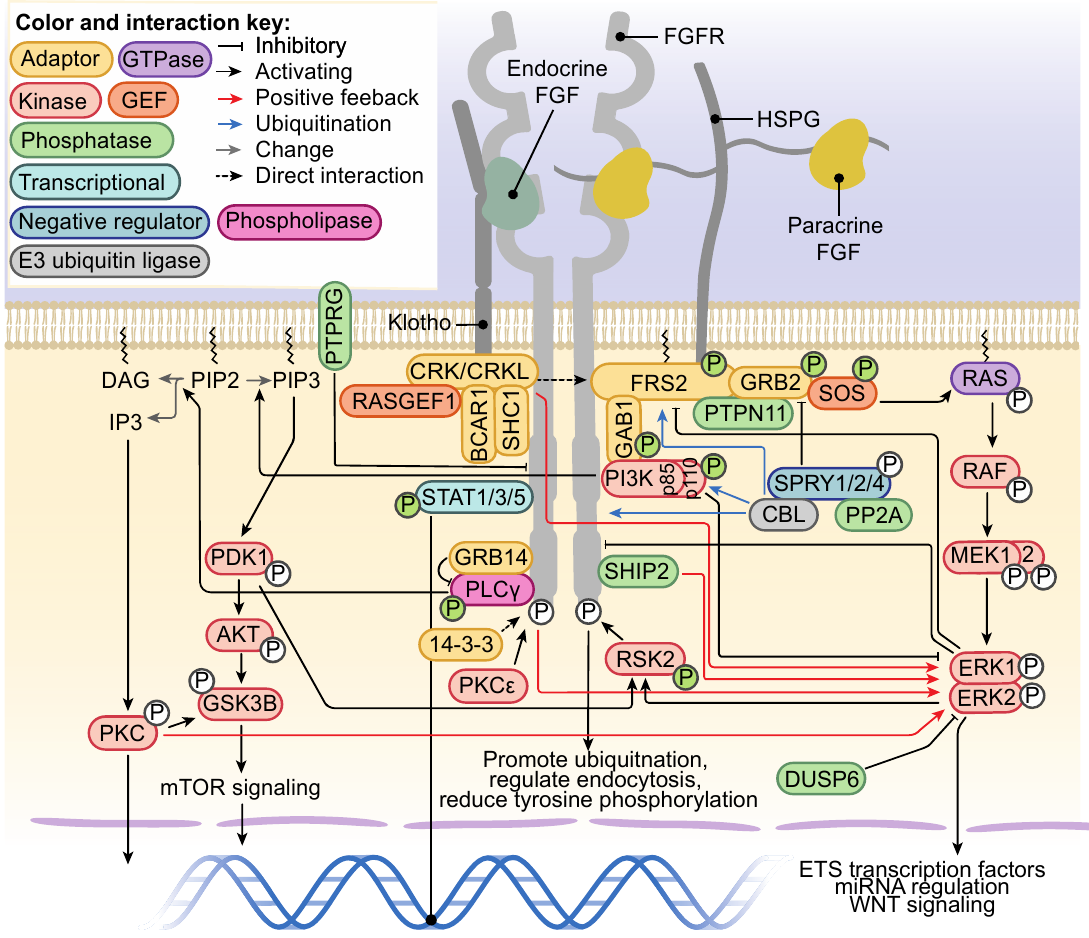
Figure 2. Fibroblast Growth Factor Receptor (FGFR) signaling partners, pathways and regulation of FGFR signaling Klotho or heparan sulfate proteoglycan (HSPG) are required for activation of FGFR by endocrine or paracrine FGFs, respectively. Binding of the ligand initiates large-scale phosphorylation and activation of intracellular signaling cascades. RAS-mitogen activated protein kinase (MAPK) and phosphatidylinositide 3-kinase (PI3K)-AKT signaling are dependent on FRS2 binding FGFR, which is associated with a CRK/CRKL complex to positively regulate extracellular signal-regulated protein kinase 1/2 (ERK1/2) signaling. ERK1/2 signaling is tightly regulated downstream of FGFR. The PI3K p85 subunit can bind FGFR independently of growth factor receptor bound 2 (GRB2)-associated binding protein 1 (GAB1) to activate AKT signaling through conversion of phosphatidylinositol 4,5-bisphosphate (PIP 2 ) to phosphatidylinositol 3,4,5-trisphosphate (PIP 3 ). PI3K-AKT signaling activates the mammalian target of rapamycin (mTOR) signaling downstream FGFR activation. PLC γ binds FGFR and hydrolyses PIP 2 to produce diacylglycerol (DAG) and inositol trisphosphate (IP 3 ). IP 3 activates protein kinase C (PKC) signaling. STAT1/3/5 activation by FGFR results in translocation to the nucleus to regulate transcription. Positive regulators of FGFR signaling include 14-3-3, protein kinase C ε (PKC ε ) and PIP 3 5-phosphatase 2 (SHIP2), whereas negative regulators include SPROUTY 1/2/4 (SPRY1/2/4), E3-ubiquitin ligase CBL (CBL), protein phosphatase 2 A (PP2A), dual specificity phosphatase 6 (DUSP6) and protein tyrosine phosphatase receptor type G (PTPRG). Phosphorylation colored green indicates proteins where activation is dependent on FGFR-mediated tyrosine phosphorylation.